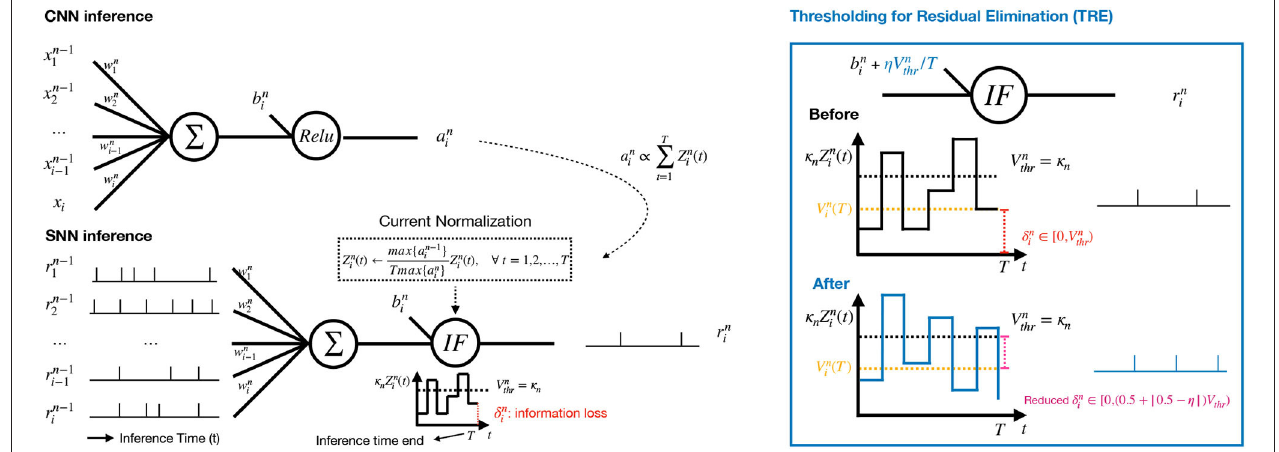
FIGURE 2 | Left : Our proposed CNN-to-SNN conversion for the n -th layer with a current normalization component and a thresholding mechanism. The activation a n i in the CNN (Top) is used for current normalization in the SNN (Bottom). Right : The proposed Thresholding for Residual Elimination (TRE) and the illustration of error reduction by